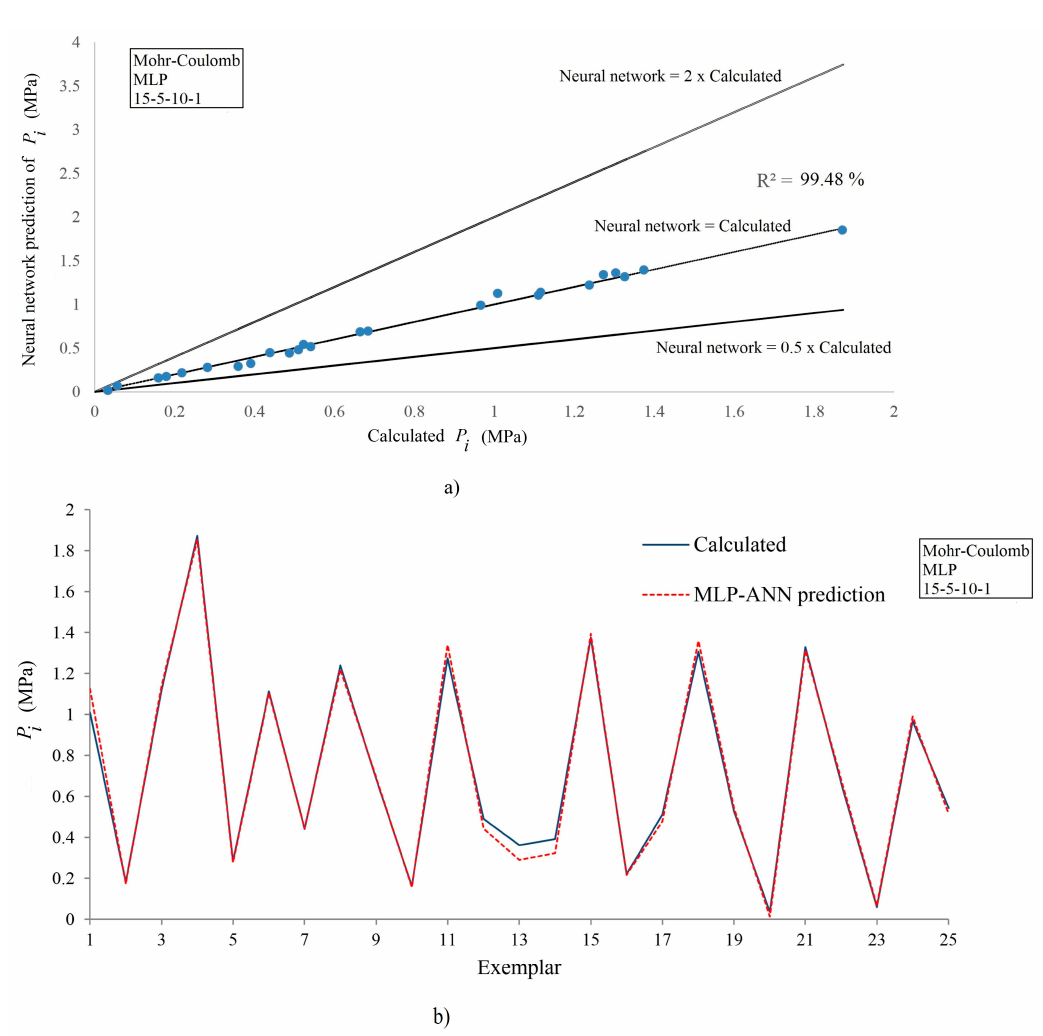
Figure 3. ( a ) ANN-based predicted P i versus calculated P i ; ( b ) differences between ANN-based predicted P i and calculated P i for the best MLP-ANN (15-5-10-1) applied to the testing data series for the Mohr–Coulomb criterion.